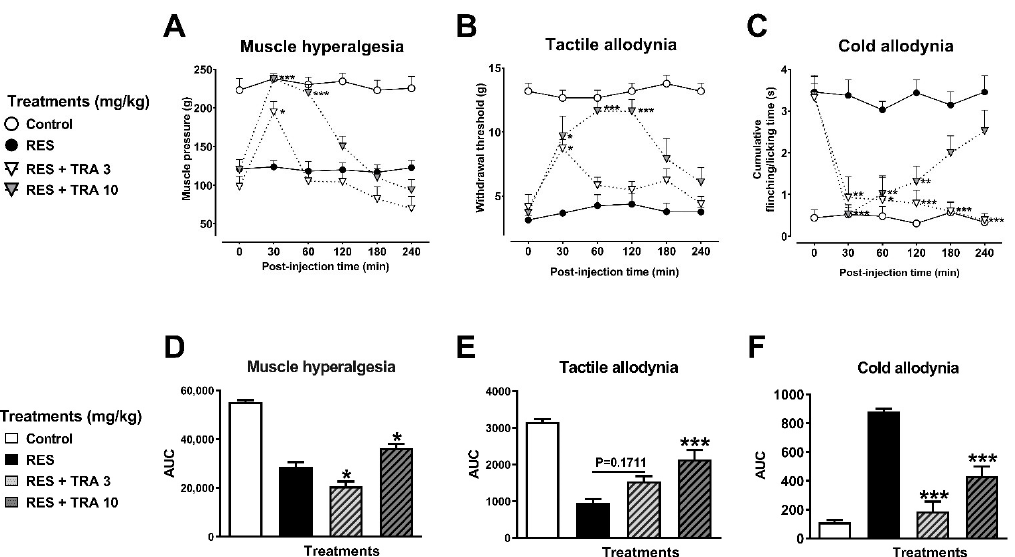
Figure 6. Antihyperalgesic and antiallodynic effect of tramadol (TRA) on the reserpine (RES)-induced nociceptive threshold. Time-course curves of the threshold to muscle pressure, shown as the force in grams supported in the right gastrocnemius muscle ( A ), the tactile response, shown as the force in grams supported on the plantar surface of the right hind limb ( B ), and cold allodynia. shown as the cumulative response time to cold stimulus (acetone) on the dorsal surface of the right hind limb for 1 min ( C ). Area under the curves of the muscle pressure threshold ( D ), tactile response ( E ), and cold allodynia ( F ). One-way ( D – F ) or two-way ( A – C ) ANOVA followed by Tukey´s test, * p < 0.05, ** p < 0.01, *** p < 0.001 vs. RES group. Regarding PRA (1 mg/kg), a maximal antihyperalgesic effect of 39% (F 5,40 = 21.50, p < 0.0001) was produced at 30 min post-injection, which exponentially decreased to reach basal values (Figure 7A,D). In the tactile allodynia, PRA (1 mg/kg) produced a significant effect of 87% (F 5,40 = 40.14, p < 0.0001) (Figure 7B,E). Finally, in cold allodynia, PRA pro- duced an antinociceptive effect from 64% to 95% (F 5,40 = 53.56, p < 0.0001) at all tested doses (Figure 7C,F). In both tactile and cold allodynia, the effect was observed from the first 30 min and remained until the end of the experiment (240 min after s.c. injection).